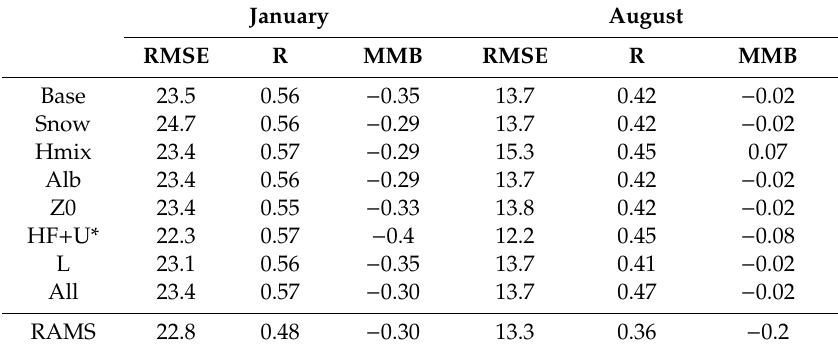
Table 3. NO 2 —monthly Root Mean Square Error (RMSE) ( µ g / m 3 ), Correlation Coe ffi cient (R) and Modified Mean Bias (MMB). Values in bold indicate that performance improved (lower RMSE and MMB, higher R) with respect to the Base